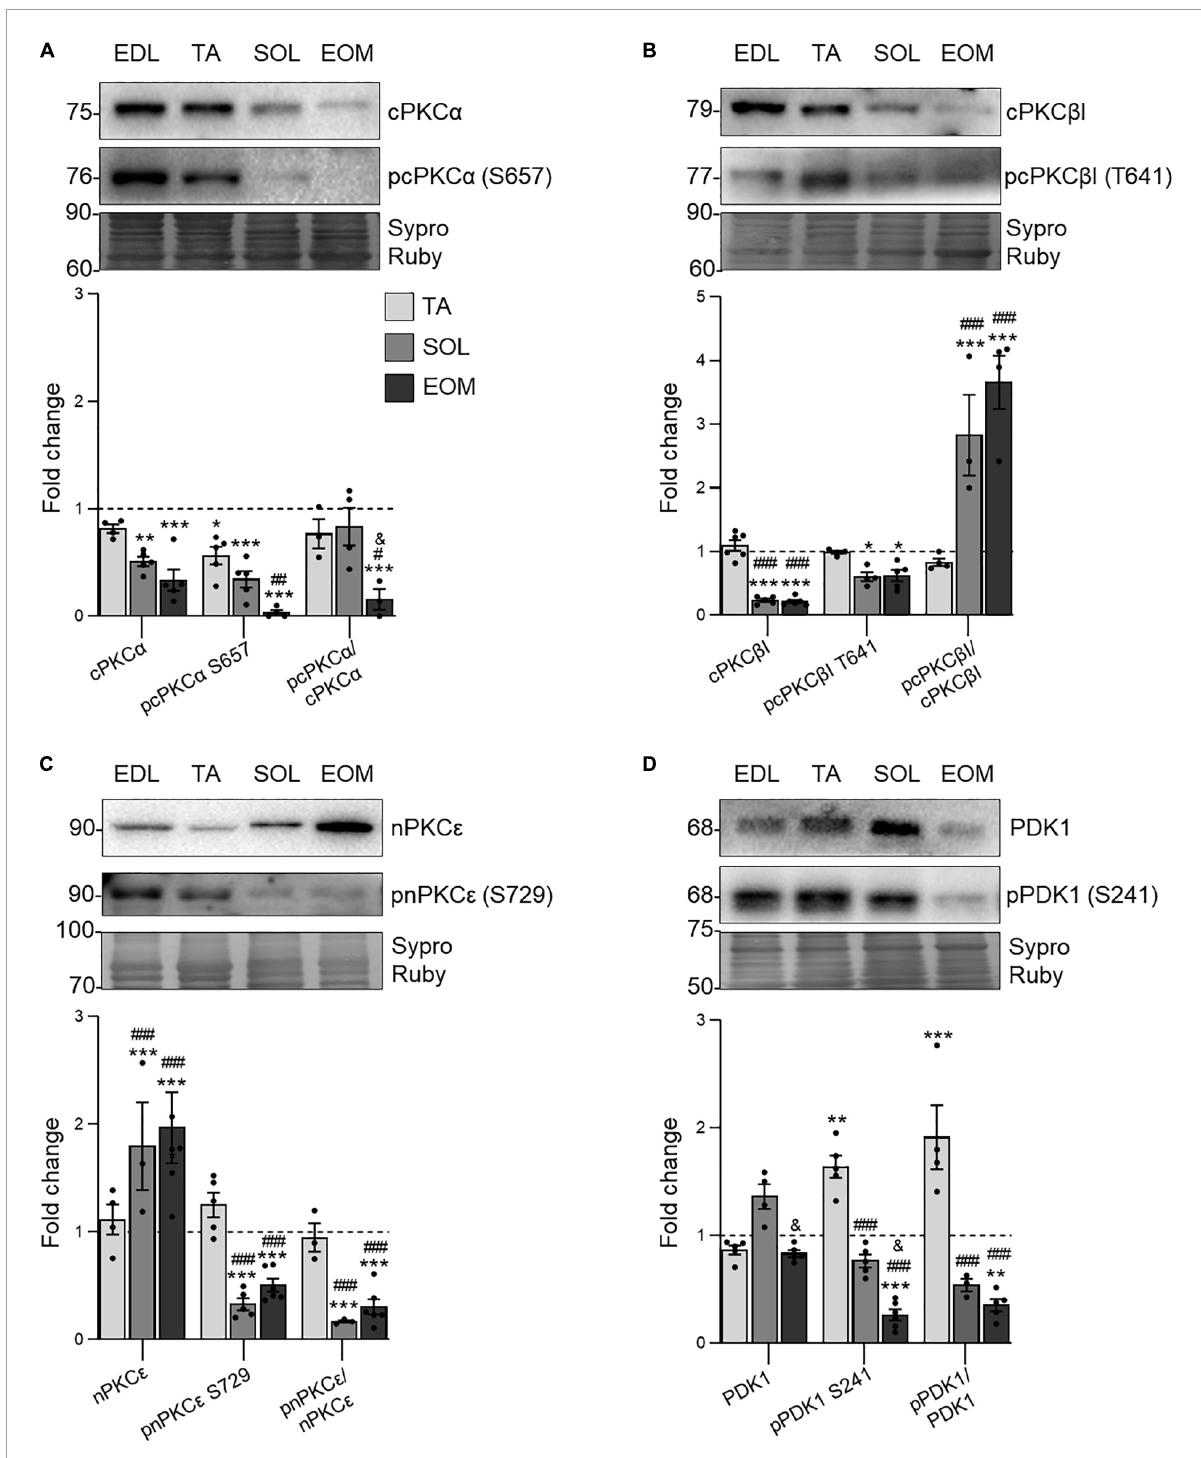
FIGURE3 PKC isoforms and PDK1 expression changes in EDL, TA, SOL, and EOM of Sprague Dawley rats. Western blot analysis and data quantification of (A) PDK1, (B) cPKC α , (C) cPKC β I, and (D) nPKC ε protein levels in different muscles. Sypro Ruby images show the region surrounding each protein of interest despite the bands’ optical densities being normalized using the full length of the lanes. Data are presented as mean ± SEM. Each circle in the bars is the mean result of one animal. * P ≤ 0.05; ** P ≤ 0.01; *** P ≤ 0.001; *against EDL, # against TA, & against SOL (Kruskal–Wallis test and Dunn’s post-hoc test). EDL, Extensor Digitorum Longus; TA, Tibialis Anterior; SOL, Soleus; EOM, Extraocular Muscles. Graphs done with GraphPad Prism software, San Diego,